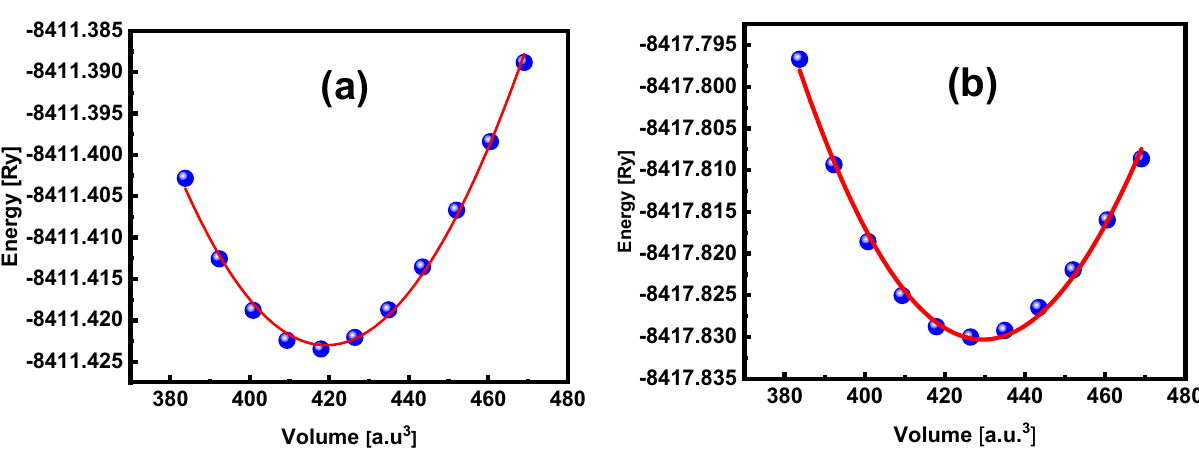
Figure 2. Volume-optimization curve of alkali (Na)-based ( a ) niobate (NaNbO 3 ) and ( b ) tantalate (NaTaO 3 ), fitted with Birch–Murnaghan